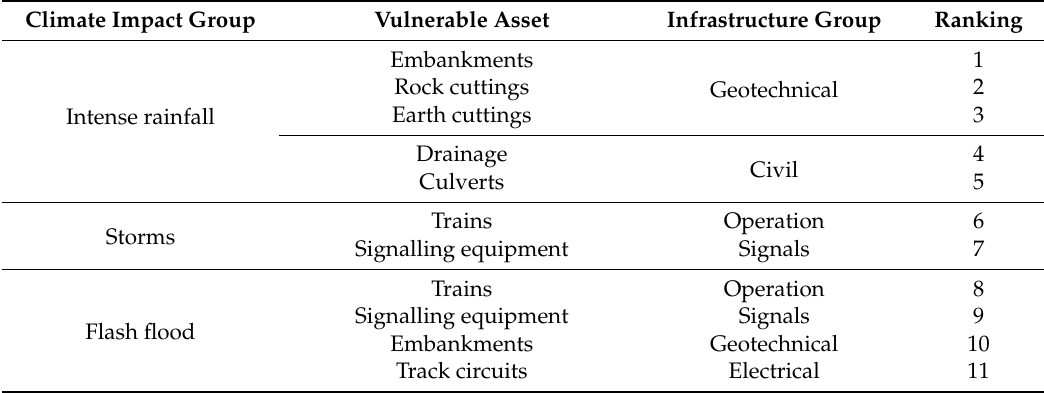
Table 1. Risks and vulnerable assets of high speed rail infrastructure in